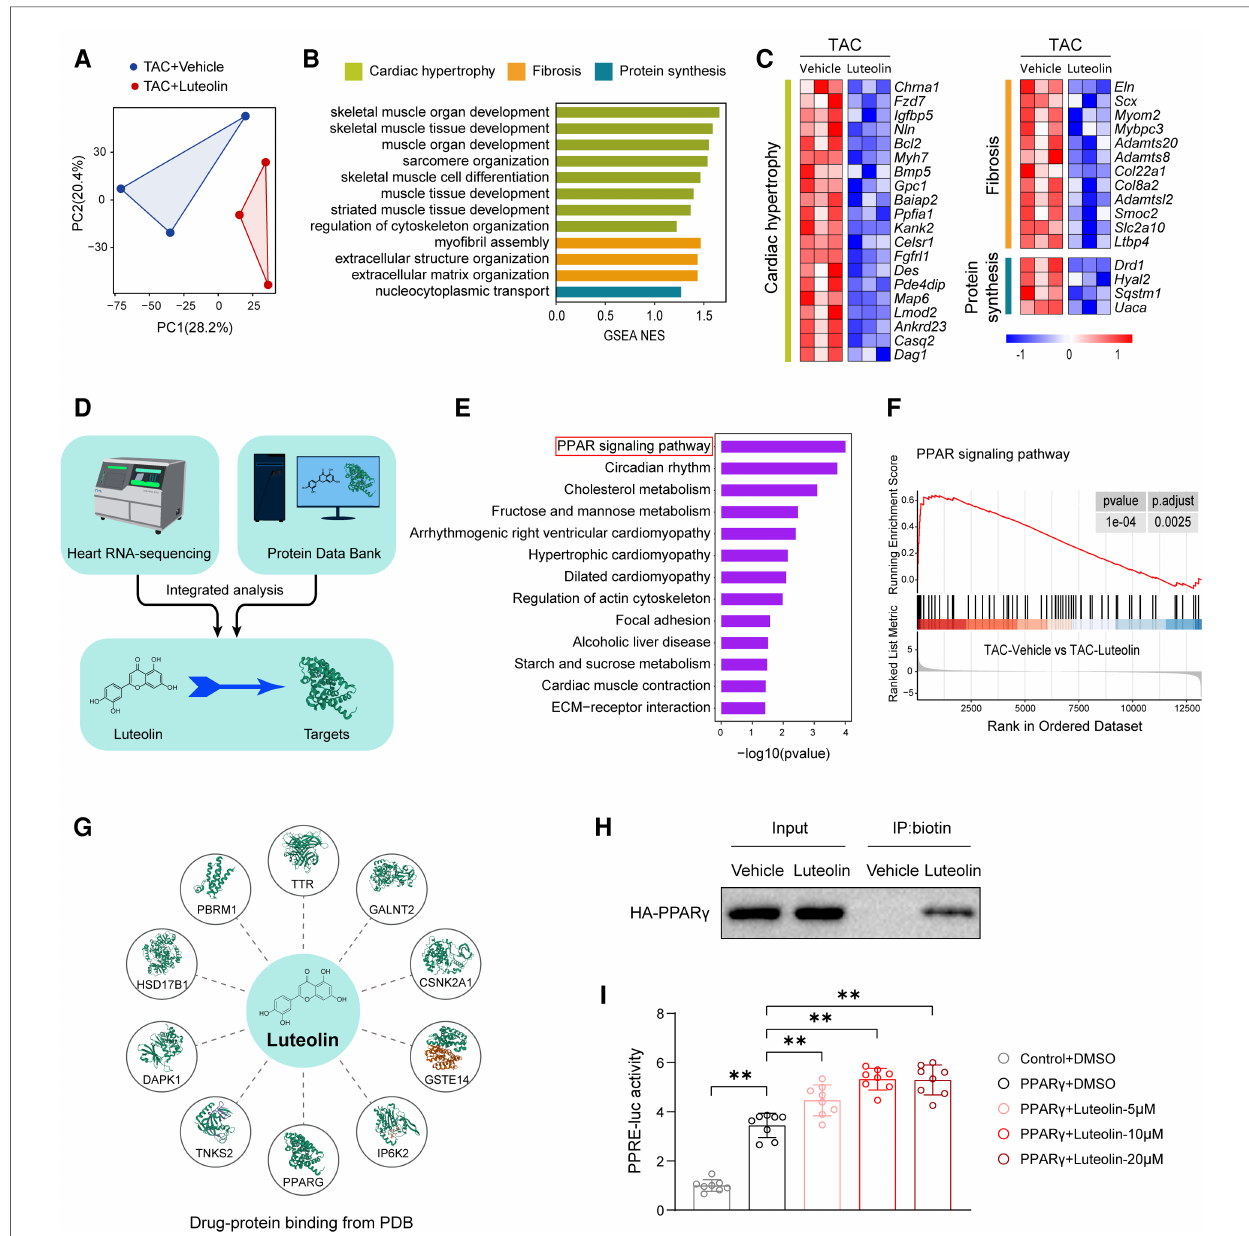
FIGURE 6 Luteolin directly binds to and activates PPAR γ during cardiac hypertrophy and HF. ( A ) Principal component analysis showing the global sample distribution pro fi les between groups based on the RNA-sequencing data. ( B ) Gene set enrichment analysis of molecular events involved in cardiac hypertrophy, fi brosis, and protein synthesis in RNA-sequencing data. ( C ) Heatmap showing the signi fi cantly altered genes related to cardiac hypertrophy. ( D ) Schematic diagram of the conjoint analysis. ( E ) Kyoto Encyclopedia of Genes and Genomes pathway enrichment analysis of the identi fi ed differentially expressed genes. ( F ) Individual GSEA (gene set enrichment analysis) plots of PPAR signaling pathway. ( G ) Schematic diagram of luteolin- protein binding from protein data bank (PDB). ( H ) Biotinylated protein interaction pull-down assays showing the binding of luteolin and HA-tagged PPAR γ protein in HEK 293 T cells. The data shown are representative of three independent experiments. ( I ) PPAR γ -induced PPRE luciferase activity in the treatment of luteolin at three doses (5 μ M, 10 μ M, and 20 μ M) in HEK 293 T cells. The data shown are representative of three independent experiments. Values are presented as mean±SD. ** P <0.01. PPAR γ , peroxisome proliferator activated receptor γ ; PPRE, PPAR response